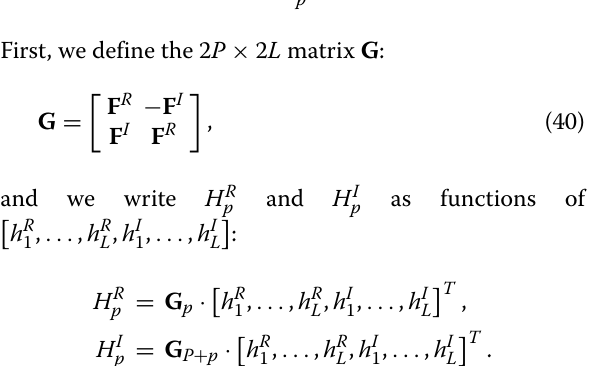
Fig. 7 Histogram of ˆ b R p , p = 1, ... , P , SNR = 10 dB, SIR = 0 dB